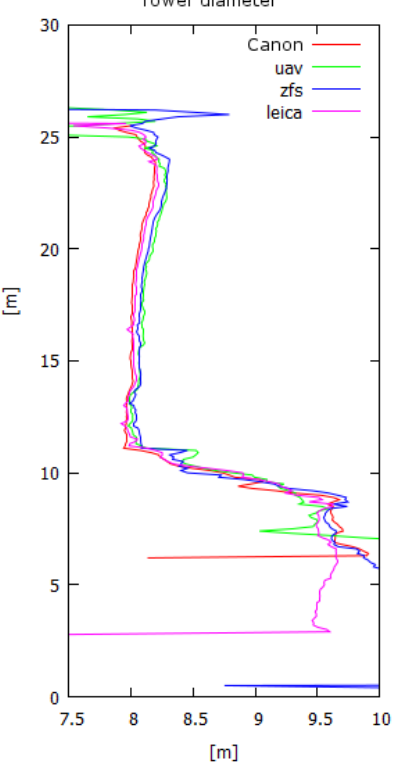
Figure 7: Diagram of the values of the tower diameter at different heights